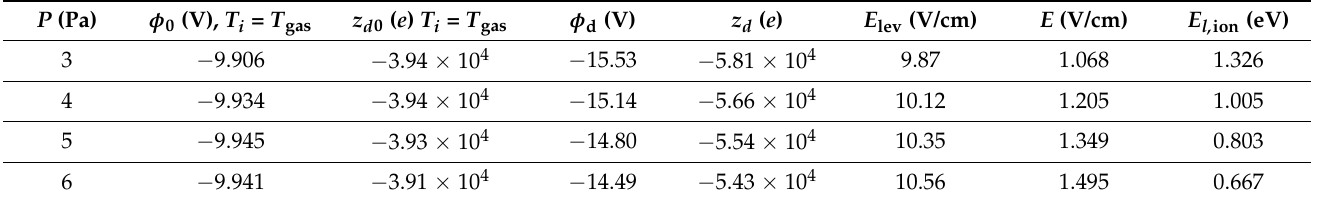
Table 3. Parameters of the RF discharge and dust particles (with radius r 0 = 5.3 µ m and density ρ = 1.5 g/cm 3 ) in the levitation area during the first series of experiments at the fixed discharge power.